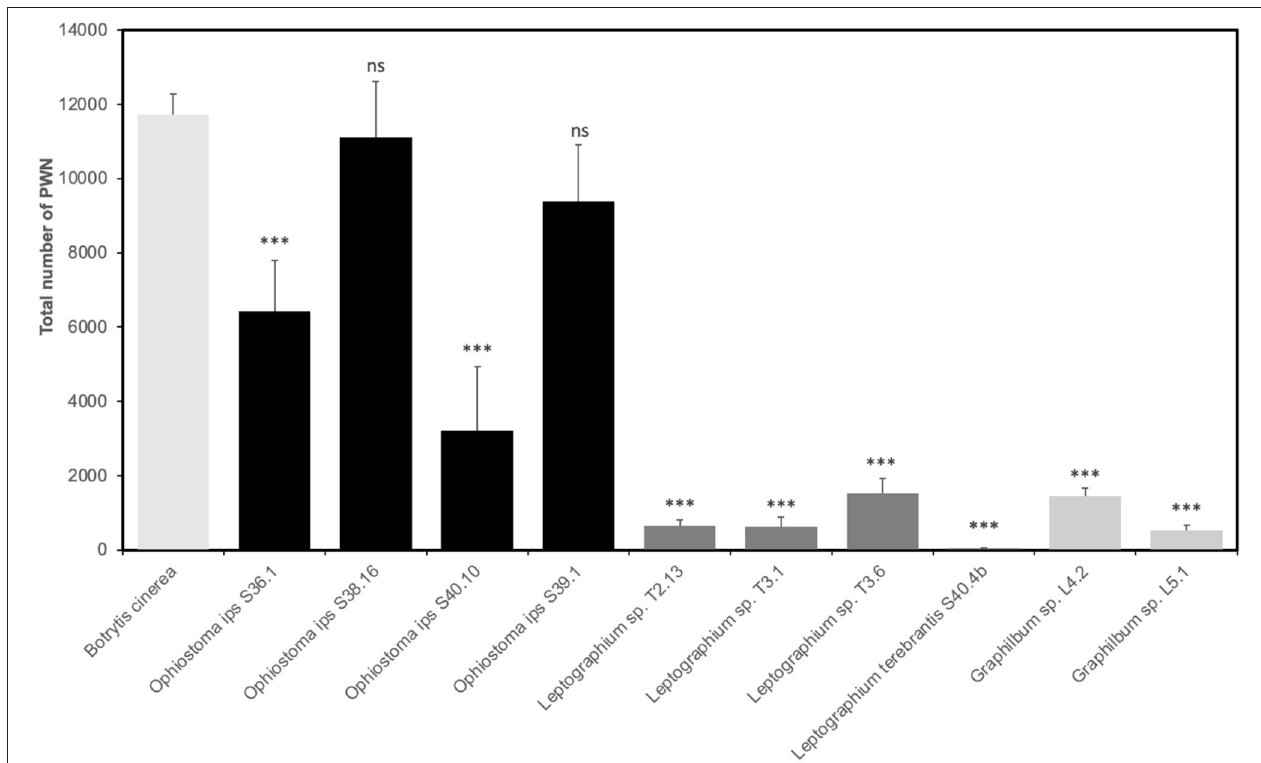
FIGURE 6 | Reproduction of Bursaphelenchus xylophilus population in each ophiostomatoid fungi and Botrytis cinerea (control) (mean total no. nematodes ± standard error). Asterisks (***) indicate statistical differences at 99% of confidence in relation to B. cinerea